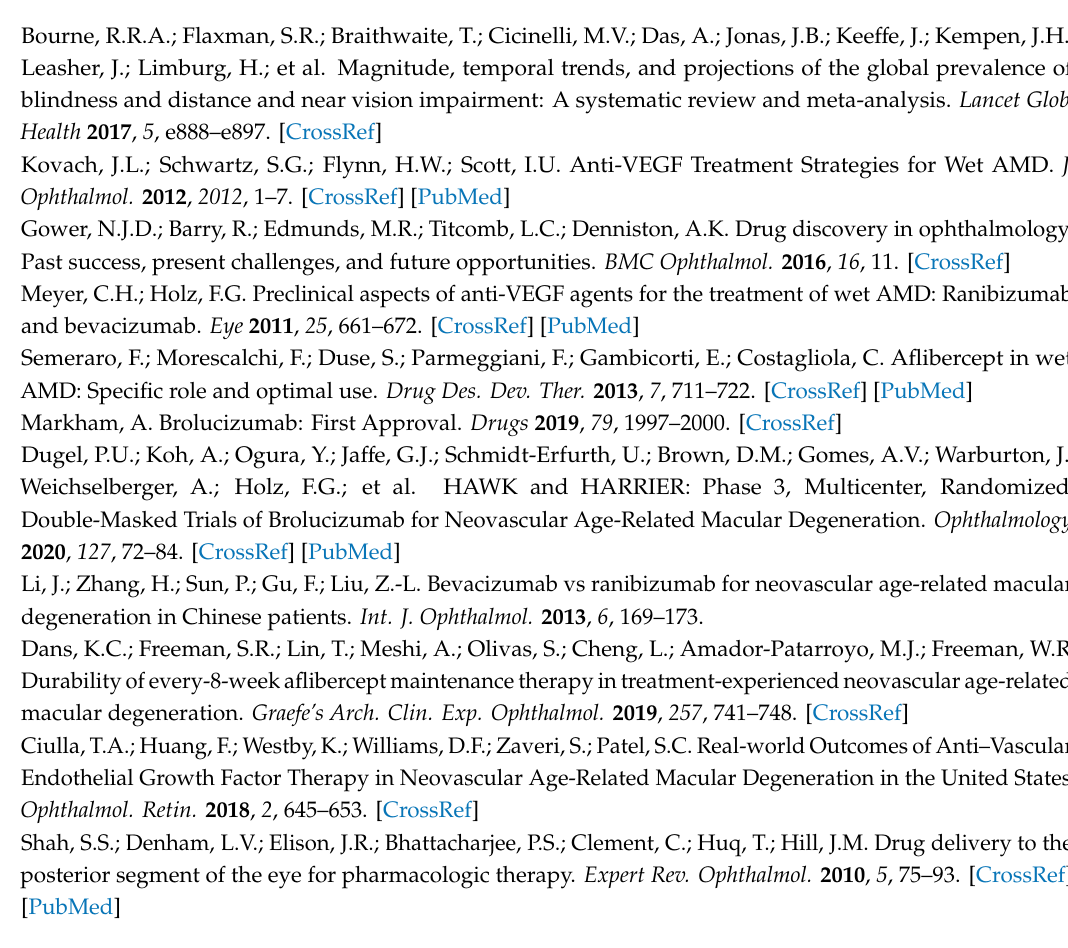
Table S1: Summary of individual concentration-time data measured in rabbit plasma, vitreous (VH) and aqueous humor